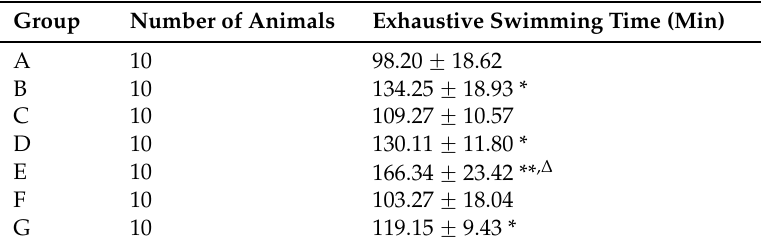
Table 6. Exhaustive swimming time of